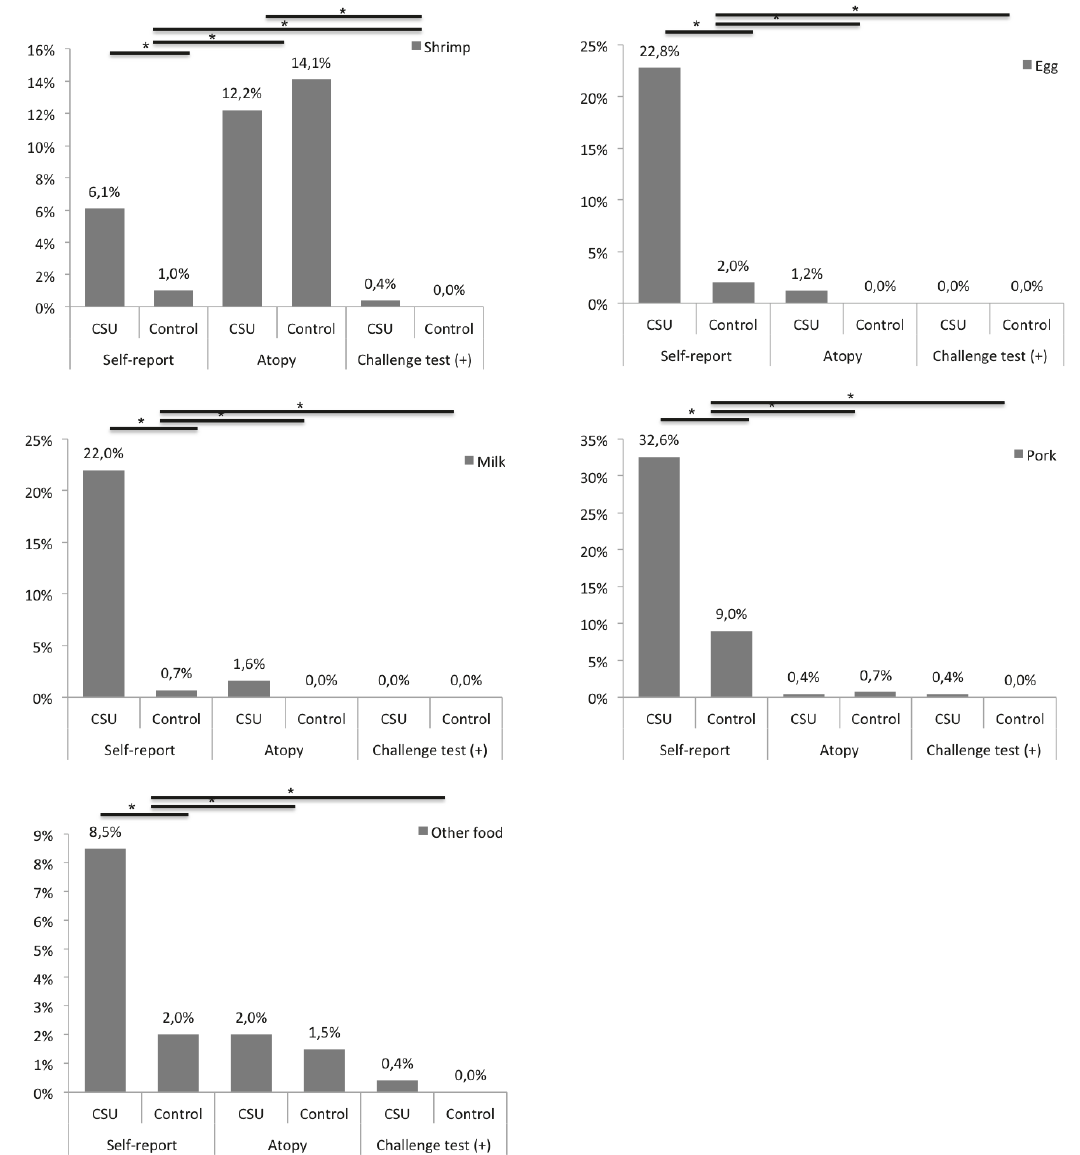
Figure 3: Results of self-report, sensitization, and challenge test for the main suspect foods. Percentages are based on the total number of patients with CSU or control group. ∗ 𝑝 <